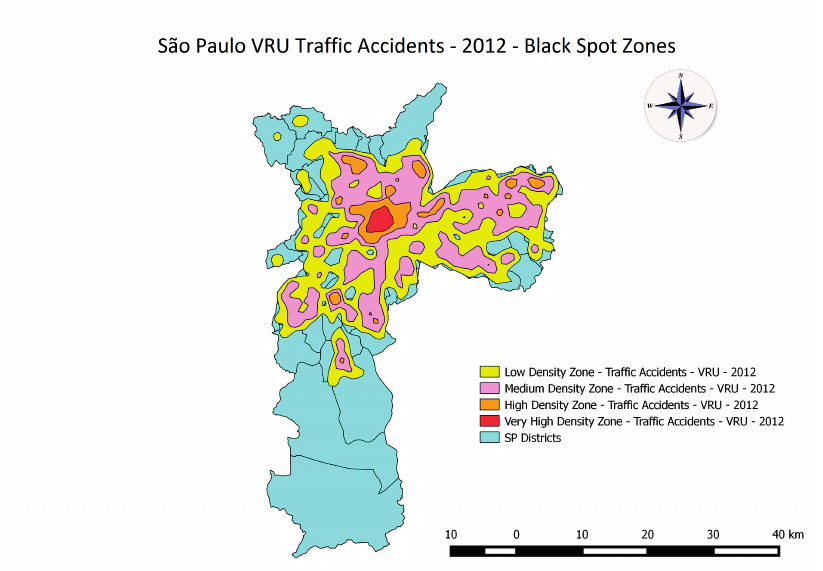
Figure 5. Black spot zones. Traffic accidents involving VRU in São Paulo in